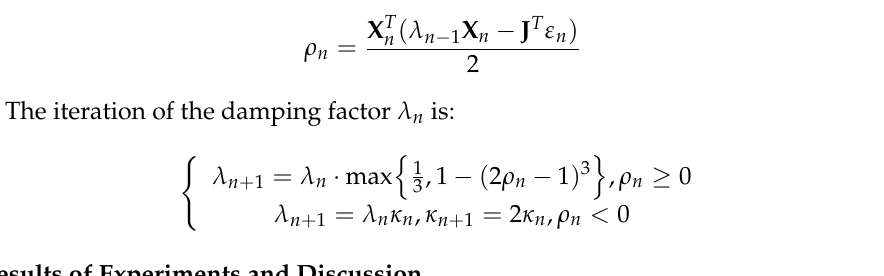
Table 2. The identified position and orientation parameters of laser beams. k